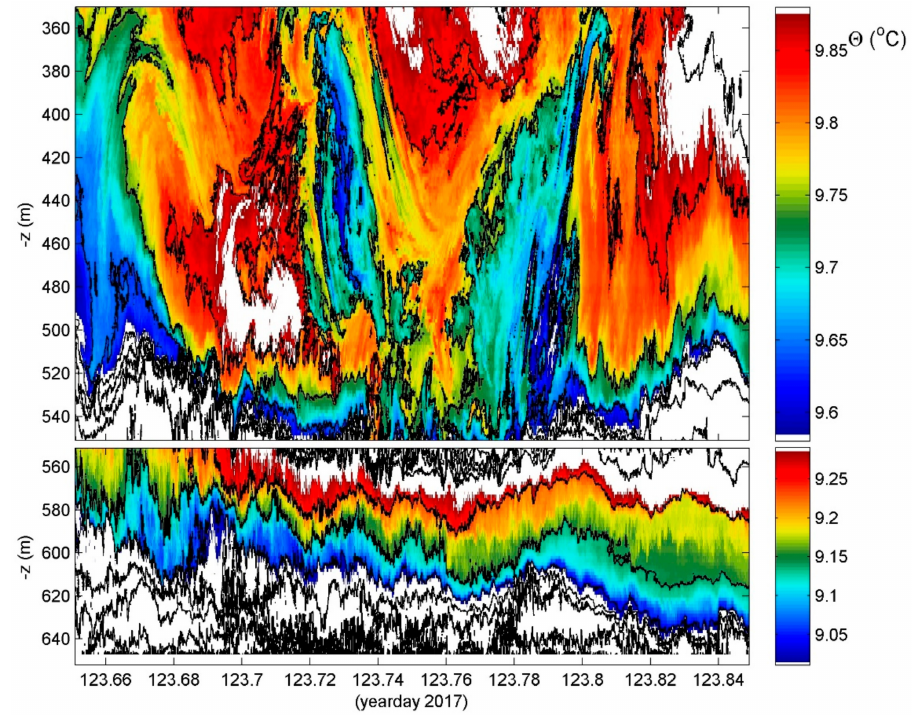
Figure 7. Just over 4 hours, a 300-m range example of above Haas mound off Rockall Bank, NE Atlantic (55 ◦ 25 (cid:48) N, − 15 ◦ 45 (cid:48) W, H = 650 m water depth, 199 T-sensors @1.5 m). The depth-range is split in two panels with different color ranges for better visualization. In the lower panel, the horizontal axis is at the sea